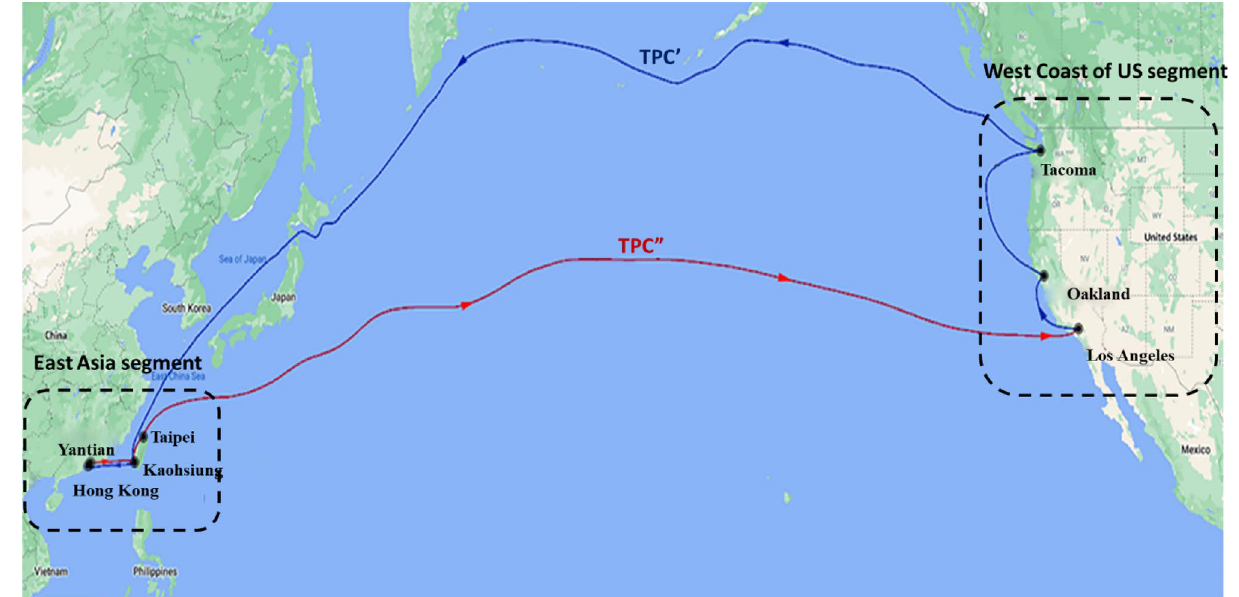
Figure 1. The round-trip voyage of the container ship starting from the Port of Los Angeles. Map retrieved from Google Maps (Map data @ 2022 Google). The blue line represents the transpacific crossing (TPC ′ ) to the East Asian ports (EA), while the red line represents the transpacific crossing (TPC ″ ) back to the West Coast (WC). The distances in WC = 1145 nmi; TPC ′ = 6561 nmi; East Asia = 949 nmi; and TPC ″ = 5949 nmi. (Figure prepared with Adobe Photoshop 21 - https:// www. adobe.